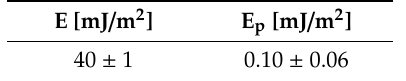
Table 6. Surface free energy (E) of neat polymer matrix and its polar component (E p ). E [mJ / m 2